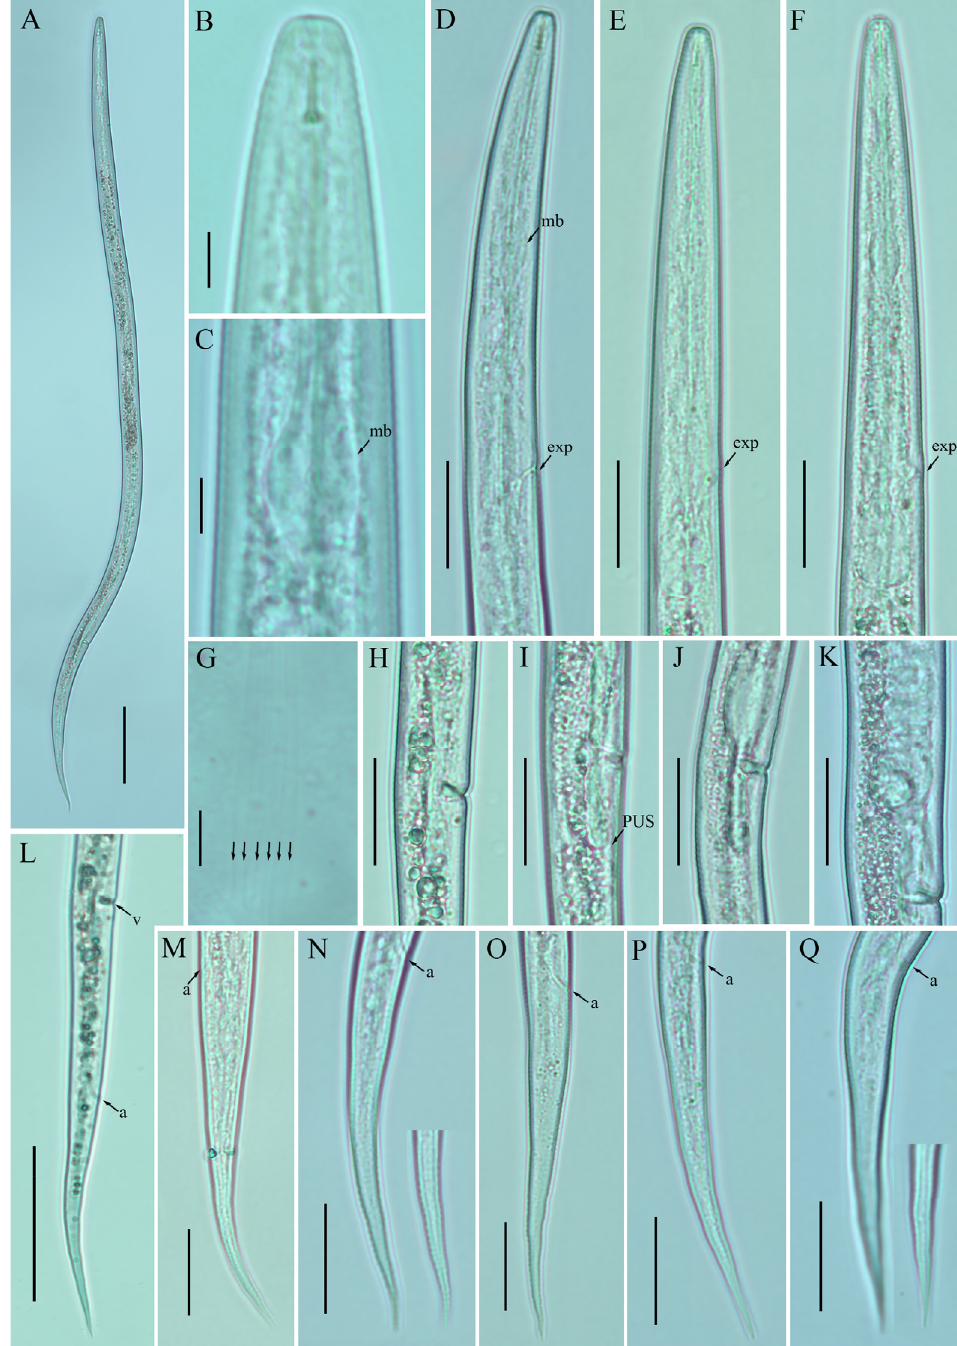
Figure 3. Photomicrographs of female Ditylenchus tenuidens Gritsenko [41] ( A ) Entire body; ( B ) lip region; ( C ) median bulb; ( D – F ) pharyngeal regions; ( G ) lateral field lines; ( H – K ) vulval regions; ( L ) posterior body to tail terminus; ( M – Q ) tail regions. Scale bars: ( A , L ) 50 µ m; ( B , C , G ) 5 µ m; ( D – F , H – K , M – Q ) 20 µ m. Arrows: (a) anus; (exp) secretory–excretory pore; (mb) median bulb; (PUS) postvulval uterine sac; (v)